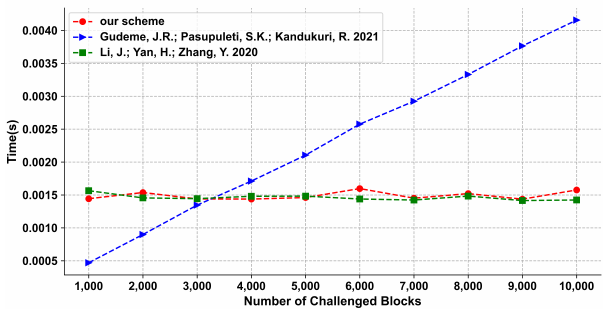
Figure 4. Computation cost of Challenge